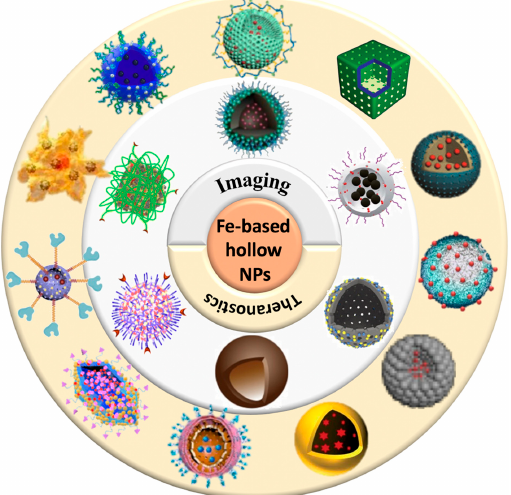
Scheme 1. Schematic illustration of various Fe-HNPs for cancer imaging and